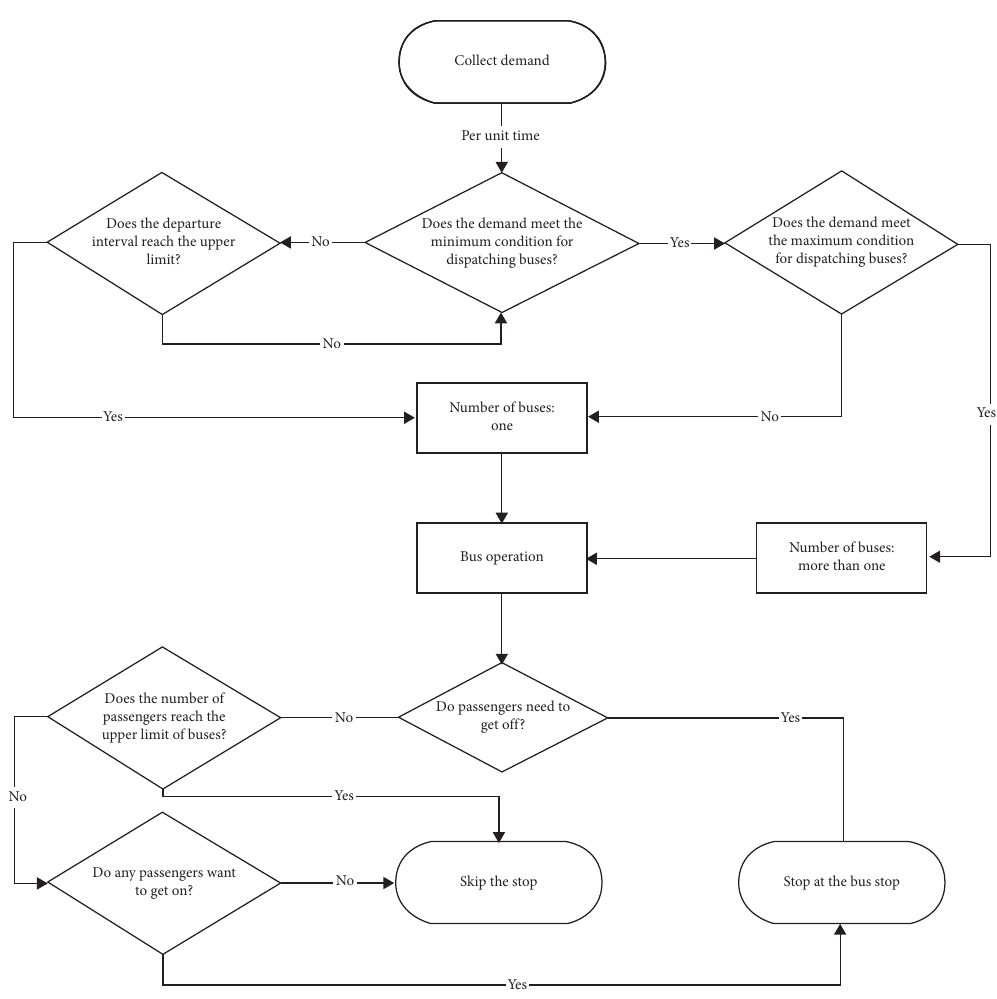
Figure 5: Algorithm of departure interval and bus